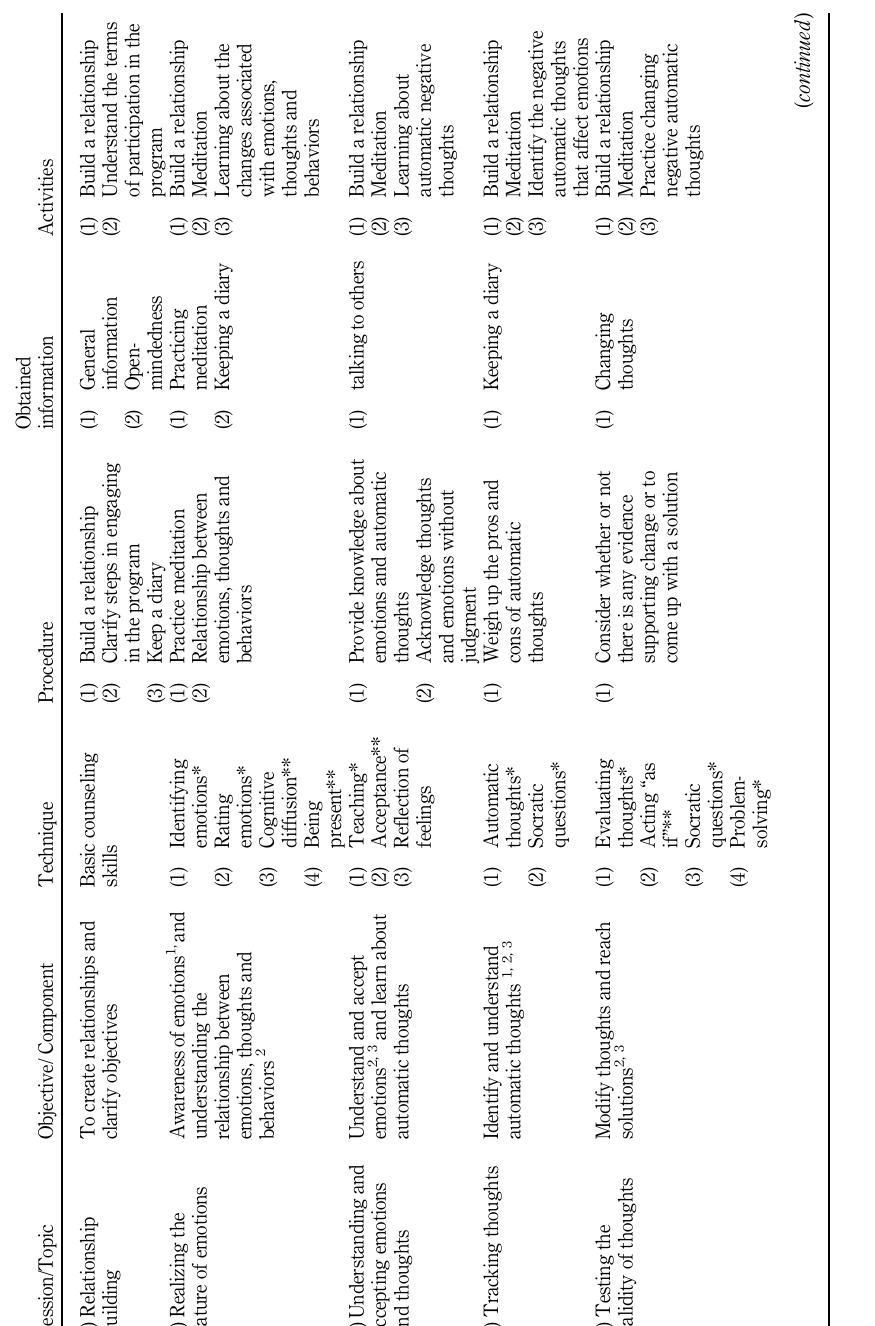
Table 2. Guidelines for